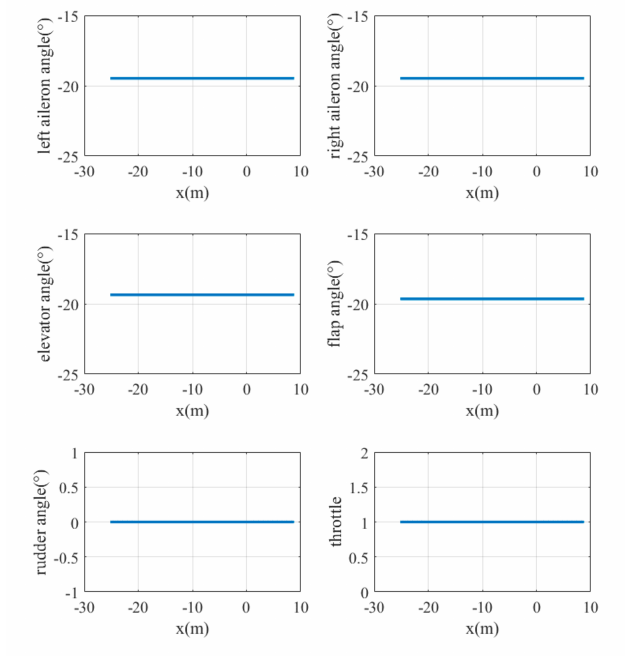
Figure 12. The control commands for the actuators under case